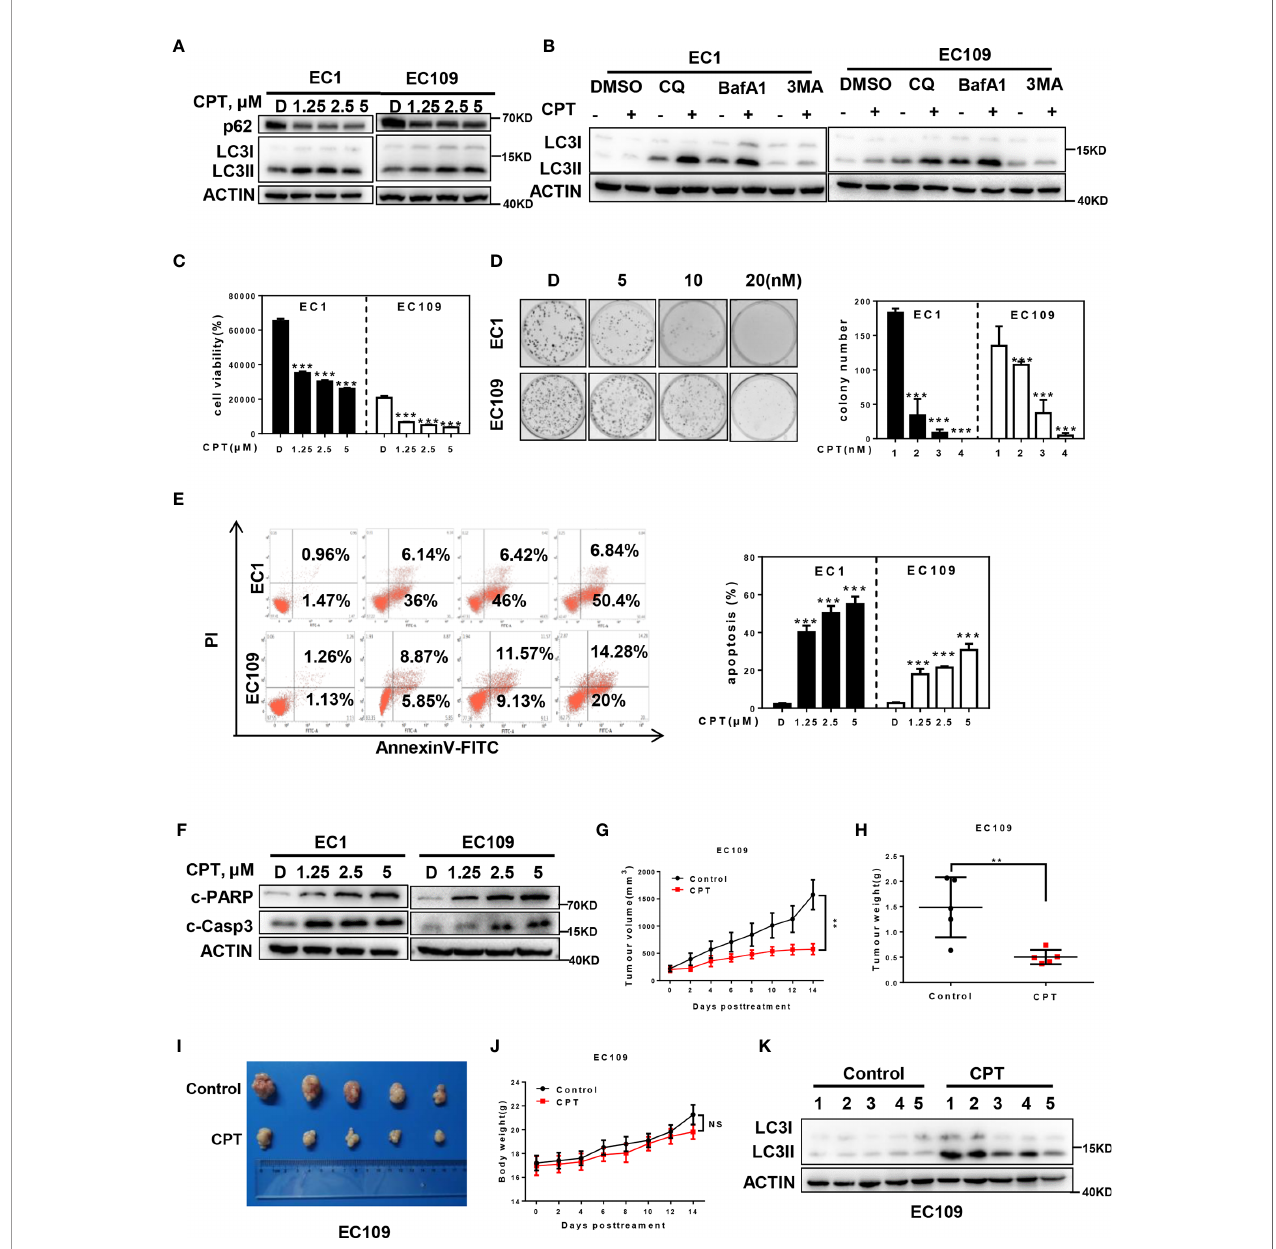
FIGURE 1 | CPT induced autophagy and suppressed the growth of esophageal cancer cells in vitro and in vivo . (A) Cells were treated with the indicated concentrations of CPT for 24 h, and cells were collected and subjected to IB analysis for the expression of LC3 and p62, Actin was used as an equal loading control. (B) Autophagic fl ux analysis. EC1 and EC109 cells treated with DMSO or CPT (2.5 m mol/L) for 24 h were incubated with or without CQ (50 m M), BafA1 (20 nM), or 3MA (5 mM) for 6 h. The treated cells were then collected and subjected to IB analysis with ACTIN as a loading control. (C) Cells were treated with the indicated concentrations of CPT for 72 h, and cell viability was assessed by the ATPLite assay ( n = 4). (D) CPT inhibited clonogenic cell survival of ESCC cancer cells. EC1 and EC109 cells were seeded into 60 mm dishes in duplicate and then grown in the presence or absence of CPT for 10 days. The colonies with more than 50 cells were counted, following crystal violet staining ( n = 3). (E, F) CPT induced apoptosis in ESCC cells. (E) Cells were treated with the indicated concentrations of CPT for 48 h and subjected to Annexin V-FITC/PI double-staining analysis ( n = 3). (F) Cells were treated with the indicated concentrations of CPT for 24 h, and cell lysates were assessed by IB with speci fi c antibodies against cleaved-Caspase-3 (c-Casp3) and cleaved-PARP (c-PARP). (G – K) CPT induced autophagy and suppressed the growth of esophageal cancer cells in vivo . Nude mice bearing esophageal cancer xenografts with EC109 cells were administered with CPT at 2.5 mg/kg. The treatments for the nude mice were carried out every 2 days and lasted for 14 days. (G) Tumor volumes were determined by caliper measurement, and the data were converted to tumor growth curves. Tumor tissues of mice were collected, photographed, weighed, and stored for further analysis ( n = 5). (H) CPT signi fi cantly reduced tumor weight ( n = 5). (I) Images of CPT-treated or control xenograft tumors at the end of experiment. (J) No obvious toxicity against body weight was observed during CPT treatment. Body weight of mice was measured twice a week during the treatment ( n = 5). (K) Proteins extracted from tumor tissues were analyzed by IB using anti-LC3. Data were presented as mean ± S.E.M. ** P < 0.01 and *** P <